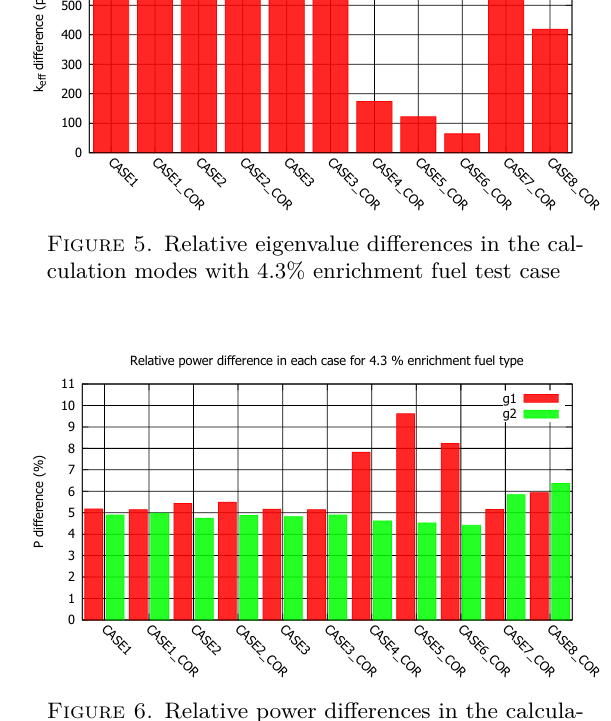
Figure 6. Relative power differences in the calcula- tion modes with 4.3% enrichment fuel test case